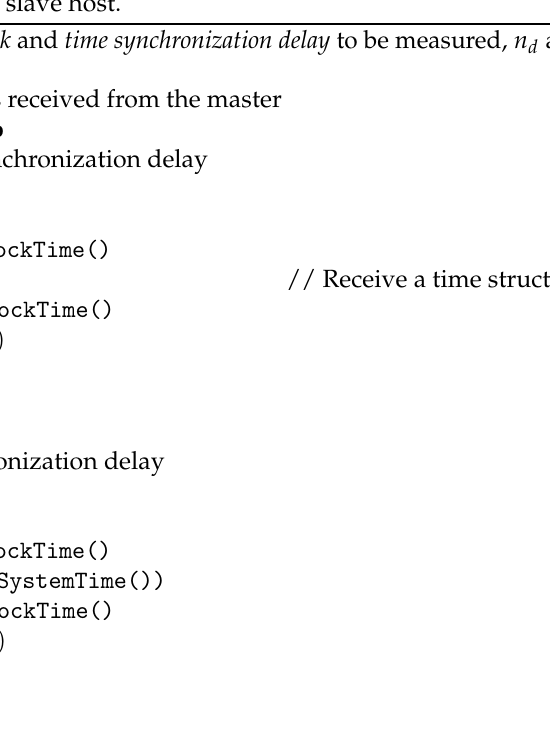
Algorithm 2: Operation at the slave